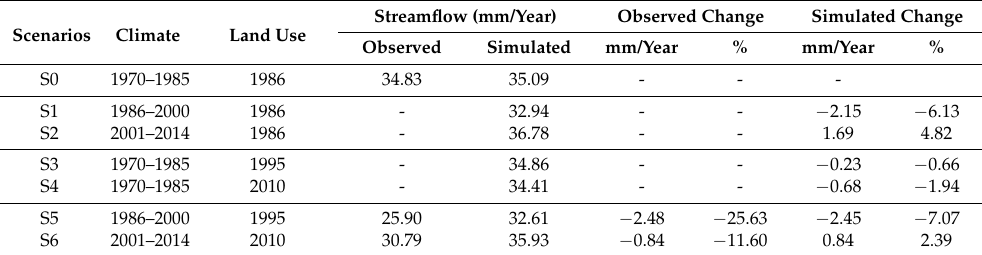
Table 8. The observed streamflow and simulated streamflow under different